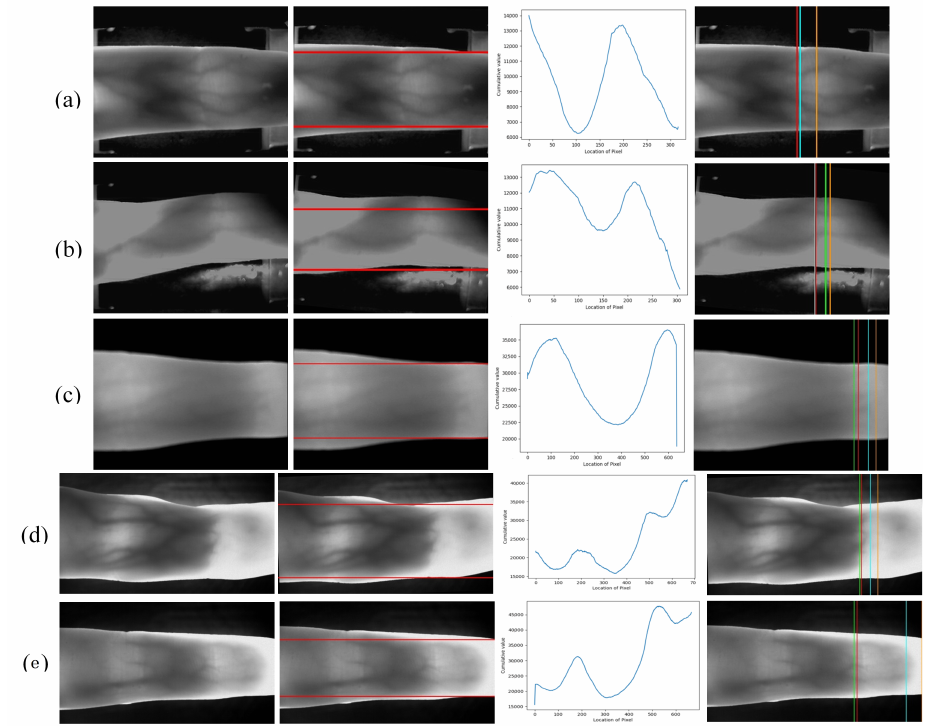
Figure 9. Comparison of different joint cavity localization methods. First column: the original images; second column: the horizontal reference lines; third column: Cumulative distribution trend for each column of pixels in the finger area; fourth column: comparisons of the effectiveness base on different methods in the joint cavity location of the